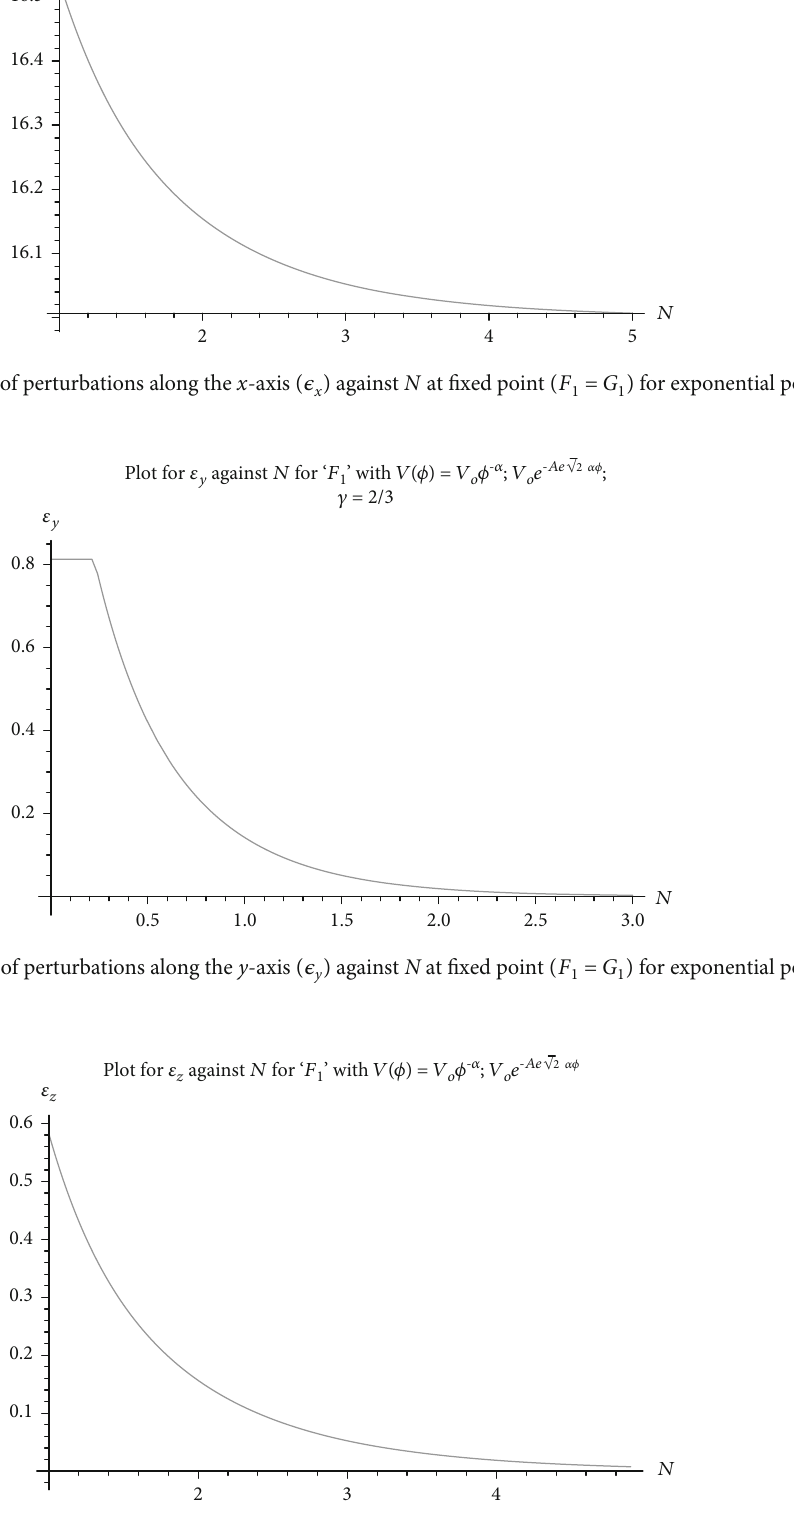
Figure 19: Shows the variation of perturbations along the z -axis ( ϵ power law